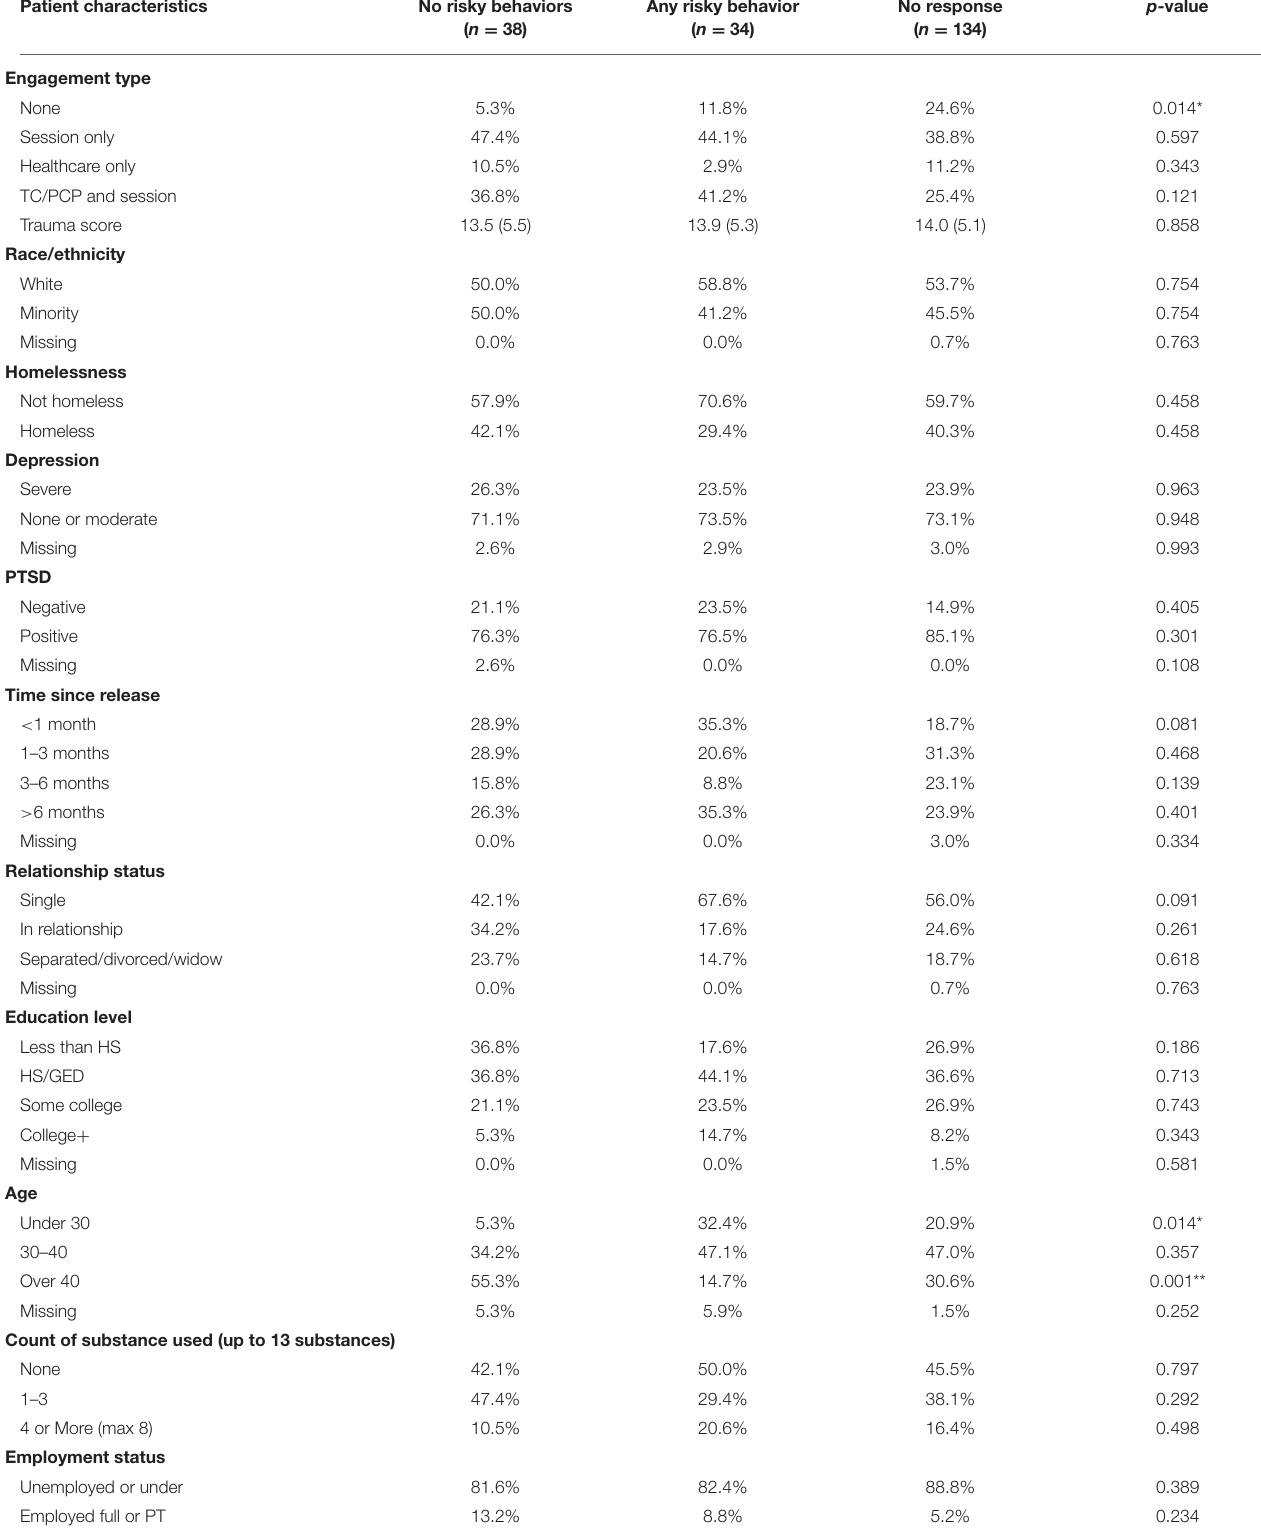
TABLE 2 | Descriptive statistics by HIV/STIs/HCV risks. Patient